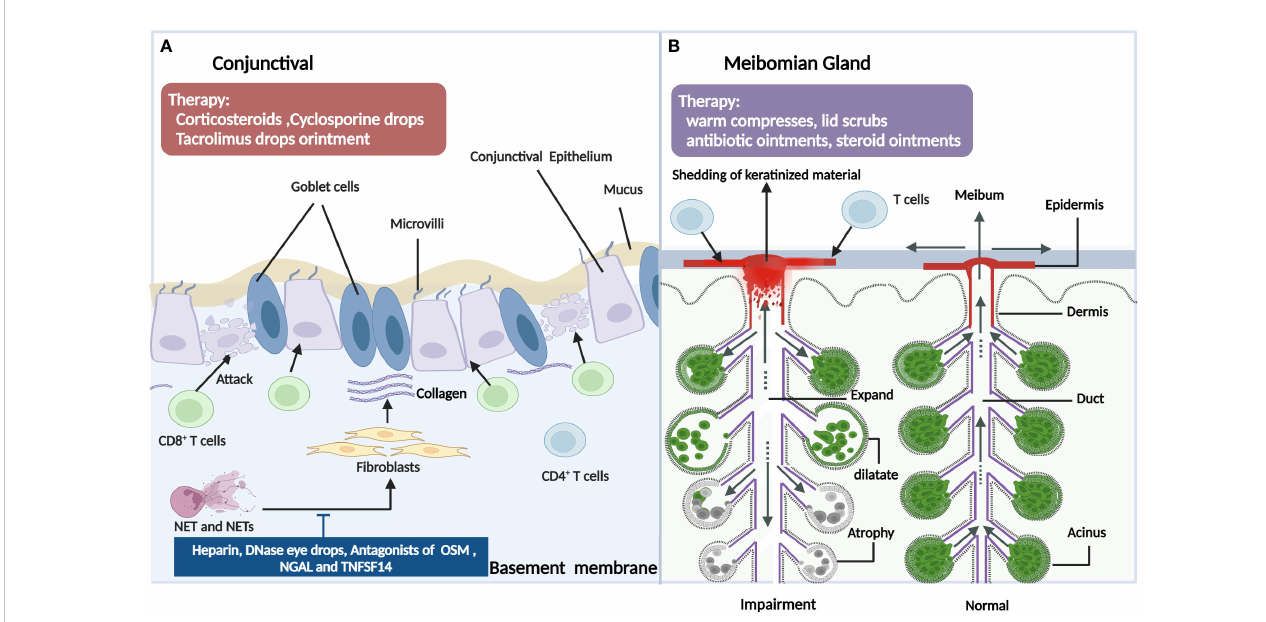
FIGURE 4 The pathogenic mechanism in the conjunctival (A) and meibomian gland (B) of ocular GVHD and treatment. 4A: In ocular GVHD patients, the conjunctival often presents as the conjunctival injection or chronic conjunctivitis, which is related with various immune cells including T cells and neutrophils (NET). By releasing nuclear chromatin complexes as extracellular DNA webs which are termed neutrophil extracellular traps (NETs), Net and Nets cause conjunctival fi broblast proliferation and differentiation and may contribute to conjunctival fi brosis. Hence, drugs such as deoxyribonuclease I; a subanticoagulant dose of heparin; and antagonists of OSM, NGAL and TNFSF14 could be potential therapies for managing ocular GVHD. In addition, more metaplasia, fewer goblet cells, a lower mean number of mucosal microvilli, and shorter microvilli also contribute to dry eye in ocular GVHD. For ocular GVHD patients with conjunctival Involvement, the therapies also include corticosteroids, cyclosporine drops, tacrolimus drops, or ointment. 4B: In fi ltration of the lymphocytes results in damage to the meibomian gland in ocular GVHD. In addition, the meibomian gland in ocular GVHD appears cystic dilatation with atrophy because of ductal epithelial hyperkeratinization, the shedding of keratinized material into the glandular ducts leading to obstructions of the ori fi ce. Patients with ocular GVHD also develop absent meibomian glands, resulting in tear fi lm instability. However, there is a lack of suitable animal models to explore the related mechanism of meibomian gland involvement in ocular GVHD to fi nd speci fi c therapeutic targets. The clinical usual treatment includes warm compresses, lid scrubs, antibiotic ointments, and steroid ointments for ocular GVHD patients with meibomian gland dysfunction. OSM, oncostatin M; NGAL, neutrophil gelatinase-associated lipocalin; TNFSF14: tumor necrosis factor superfamily member 14 (Created with